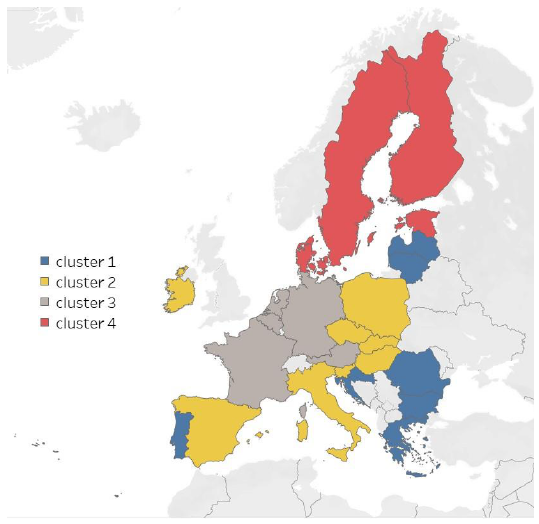
Figure 6. Choropleth map for a holistic approach. Source: Authors’ study based on [75]. The second cluster (yellow in Figures 5 and 6), including eight countries: Czechia, Hungary, Ireland, Italy, Slovakia, Slovenia, Spain, and Poland, is the cluster with the high- est values of energy productivity (X 2 ), investment rate (X 10 ), and, unfortunately, CO 2 emis- sions per km from new passenger cars (X 16 ). At the same time, they have the lowest level